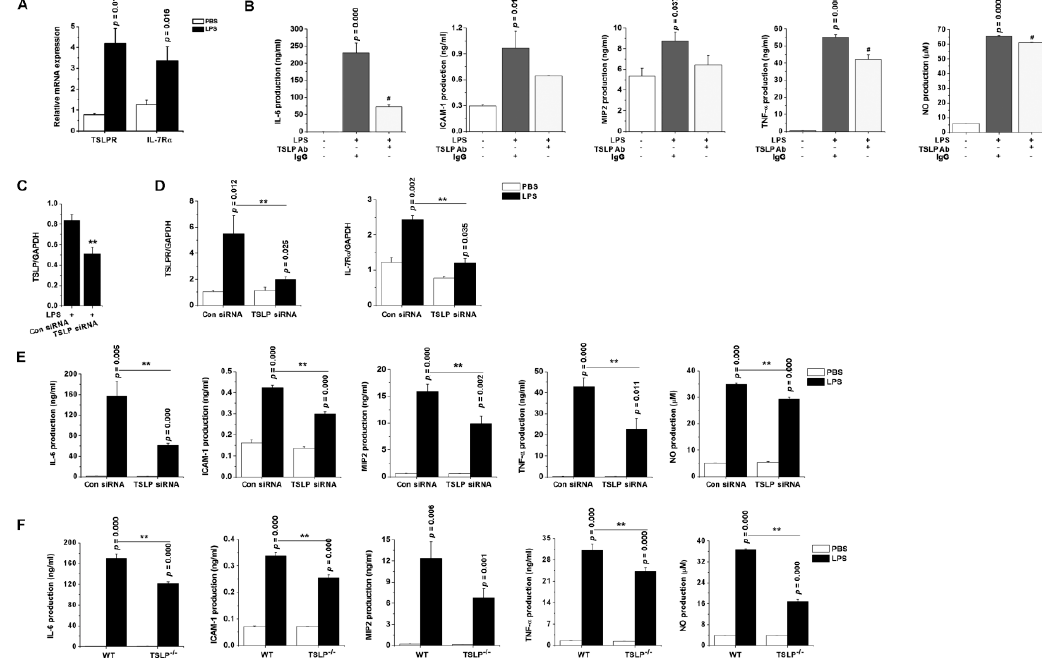
Figure 5. TSLP-dependent proinflammatory environment predisposes to the development of sepsis. ( A ) The mRNA expression of TSLPR and IL-7R α were analyzed in RAW 264.7 cells by real-time PCR. ( B ) RAW 264.7 cells were stimulated with LPS (0.1 µ g / mL) in the absence or presence of neutralizing anti-TSLP antibody (5 µ g / mL) or nonimmune IgG (5 µ g / mL) for 24 h. # p < 0.05 vs. LPS stimulation. RAW 264.7 cells were transfected with scramble control siRNA or TSLP-specific siRNA. After LPS stimulation, the mRNA expression levels of ( C ) TSLP, ( D ) TSLPR, and IL-7R α were analyzed in the transfected cells by real-time PCR. ( E ) The transfected RAW 264.7 cells were stimulated with LPS for 24 h. ** p < 0.05 vs. Con siRNA transfection and LPS stimulation. ( F ) The peritoneal macrophages isolated from TSLP − / − mice were stimulated ex vivo with LPS for 24 h. Each production was analyzed by ELISA. Nitric oxide concentration was measured by the Griess method. Data are representative of three independent experiments ( n = 5 / group). A p value indicates the significant difference between PBS and LPS. ** p < 0.05 vs. LPS-stimulated WT macrophages. PBS, phosphate-buffered saline; LPS, lipopolysaccharide; TSLP, thymic stromal lymphopoietin; Ab, antibody; Con, control; siRNA, small interfering RNA; ICAM-1, intercellular adhesion molecule-1; MIP2, macrophage inflammatory protein 2; NO, nitric oxide; WT, wild-type.